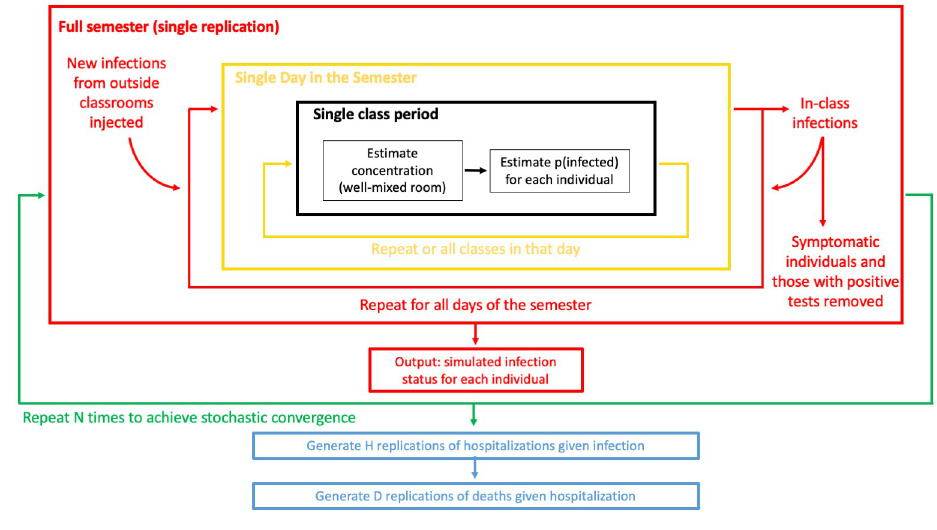
Fig 1. Overview of simulation model.